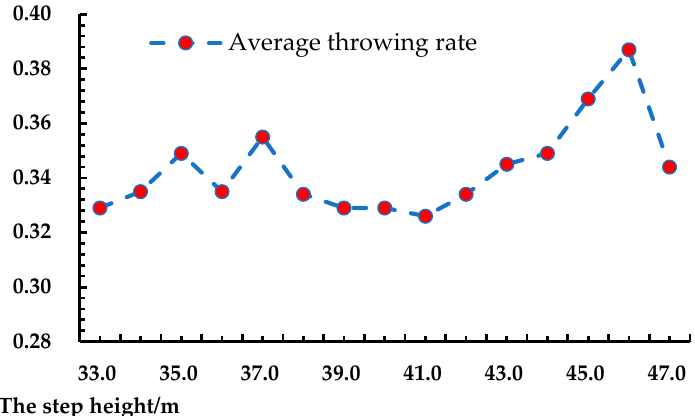
Figure 9. Frequency chart of step height.